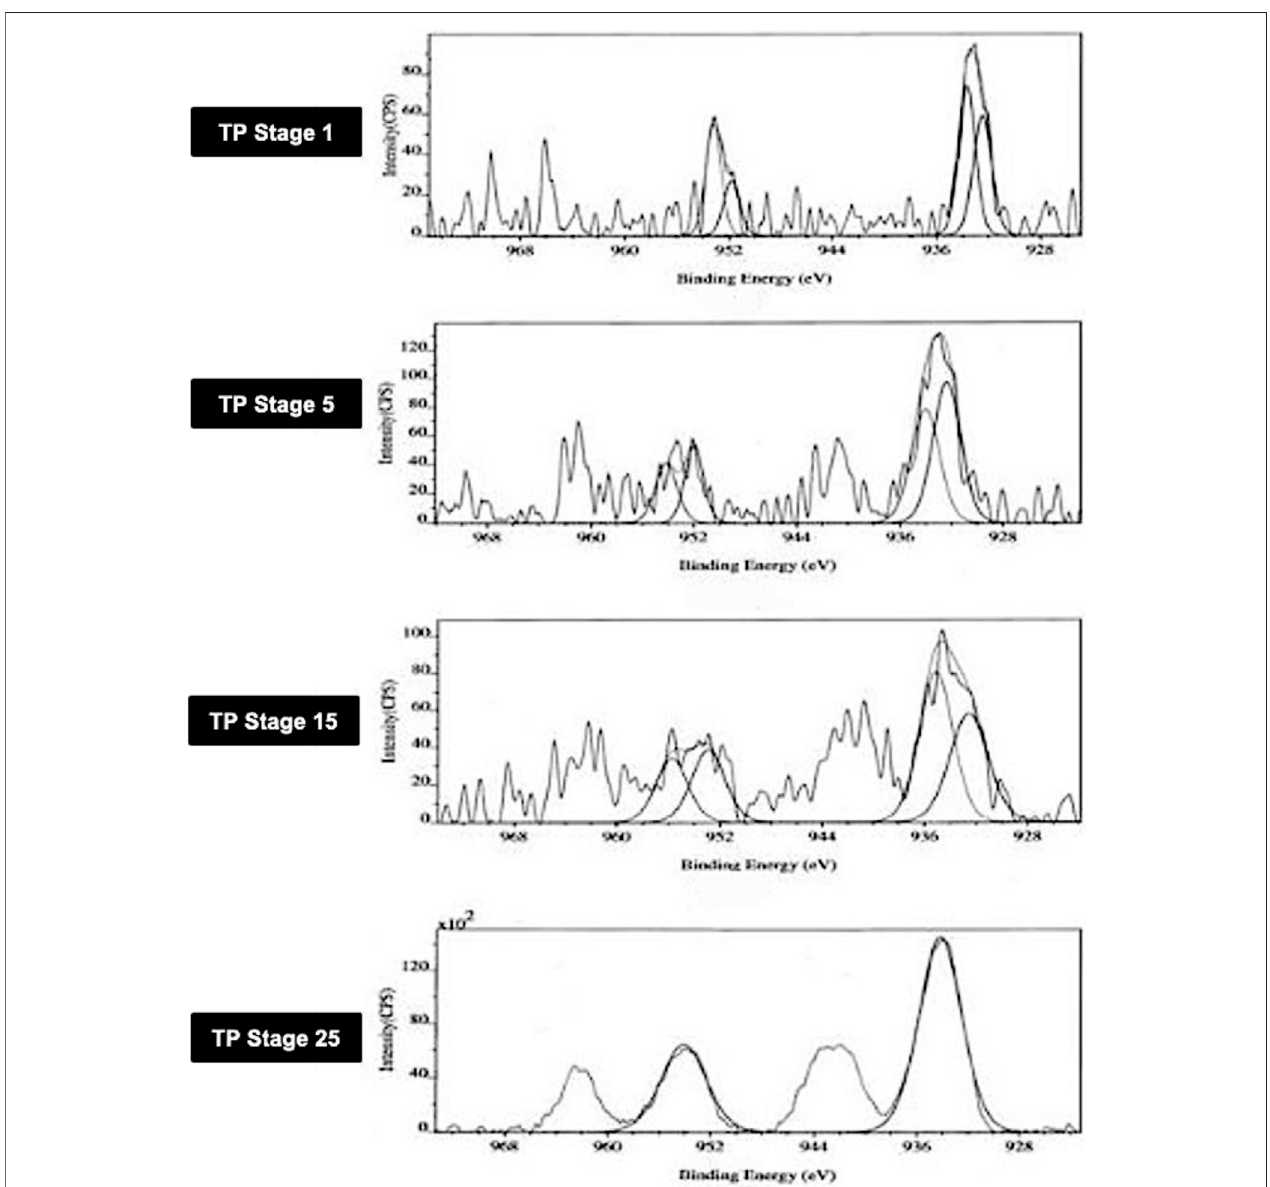
FIGURE1| Photoemissionelectron(XPS)spectraofdifferentstagesThamiraparpampreparedusingthetraditionalancientmethod,showingpeakpositionsofthe Cu2p 3/2 and Cu2p 1/2 peak of CuO (A) Stage-1 TP; (B) Stage-5 (C) Stage-15 TP (D) Stage-25 TP.